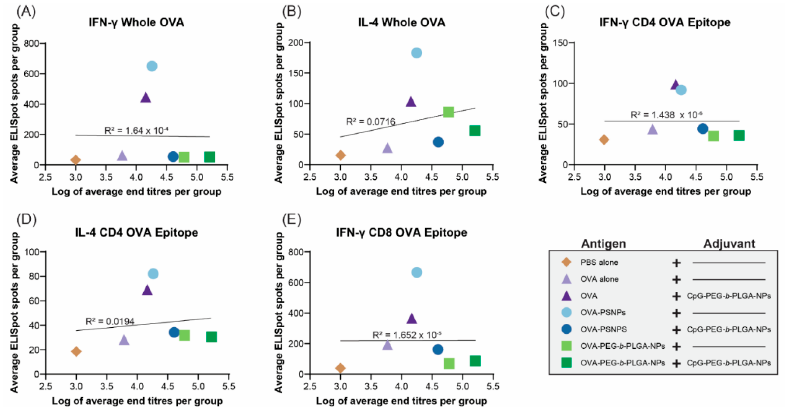
Figure 5. Correlations between cytokine levels and antibody end titers at day 28. C57BL/6 mice were immunized twice, two weeks apart, intradermally at the base of the tail with the following formulations; PBS alone (Naïve), OVA alone, OVA + CpG-PEG- b -PLGA NPs, OVA-PS NPs, OVA-PS NPs + CpG-PEG- b -PLGA NPs, OVA-PEG- b -PLGA NPs, or OVA-PEG- b -PLGA NPs + CpG-PEG- b - PLGA NPs. All animals received 50 µg OVA. CpG-PEG- b -PLGA NP groups received 5 µg CpG. Graphs show linear regression correlations between average antibody end titer (log) and the average number of IFN- γ and IL-4 producing cells from each group to ( A , B ) whole OVA, ( C , D ) CD4 + T-helper OVA epitope (ISQAVHAAHAEINEAGR), and ( E ) CD8 + cytotoxic T-cell OVA epitope